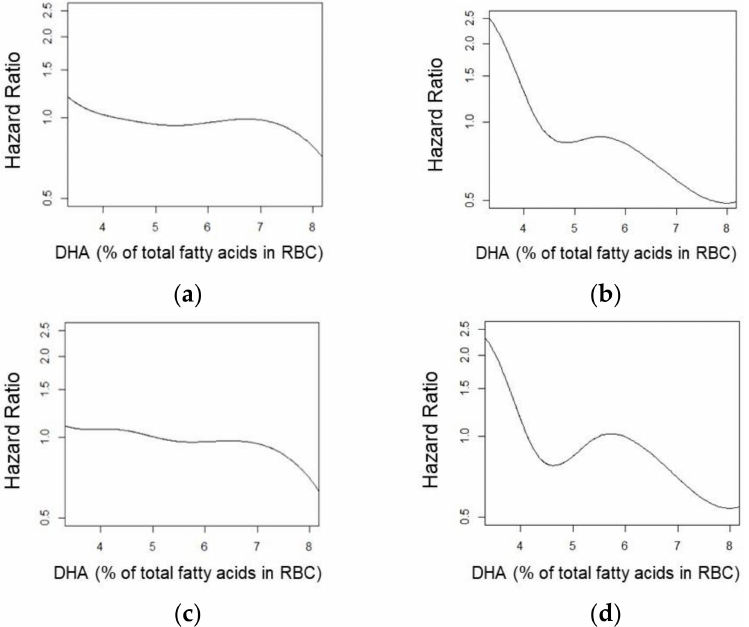
Figure 5. Splines by strata ( n = 1466) for Alzheimer’s disease ( a ) and all-cause dementia ( b ) according to the absence ( c ) or presence ( d ) of APOE- ε 4